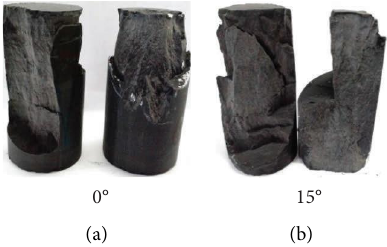
Figure 12: Fracture surface morphology of a typical splitting mode at the coring angle of 0 ° and 15 ° (the left specimen is from the scCO experimental group; the right one is from the N 2 control group). (a) 0 ° , (b) 15 ° .